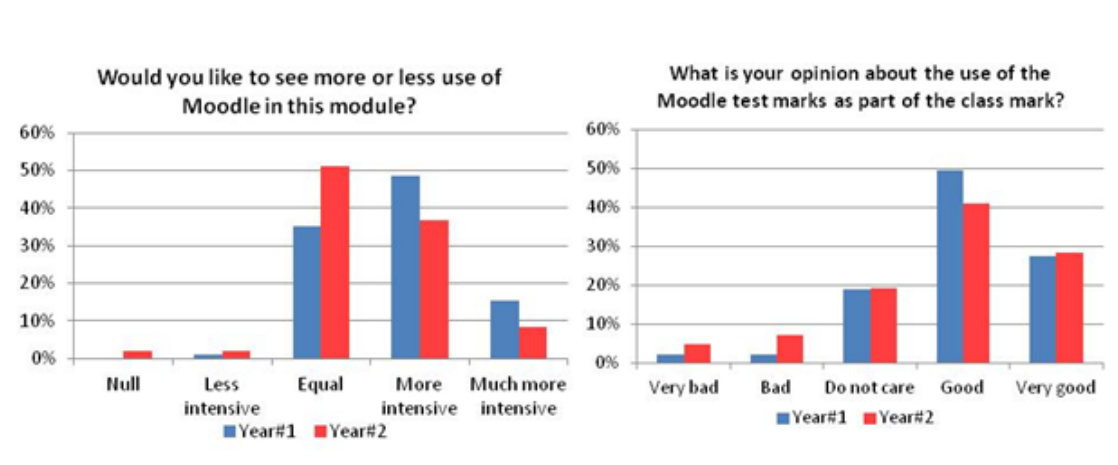
Figure 9. Opinion of the students on the use of